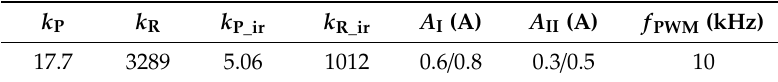
Table 2. Related parameters of the inverters.